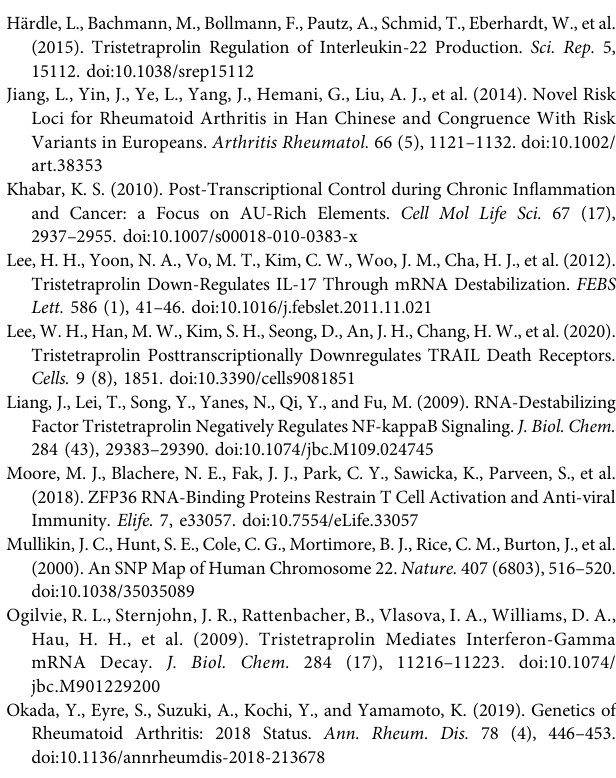
Frontiers in Pharmacology |